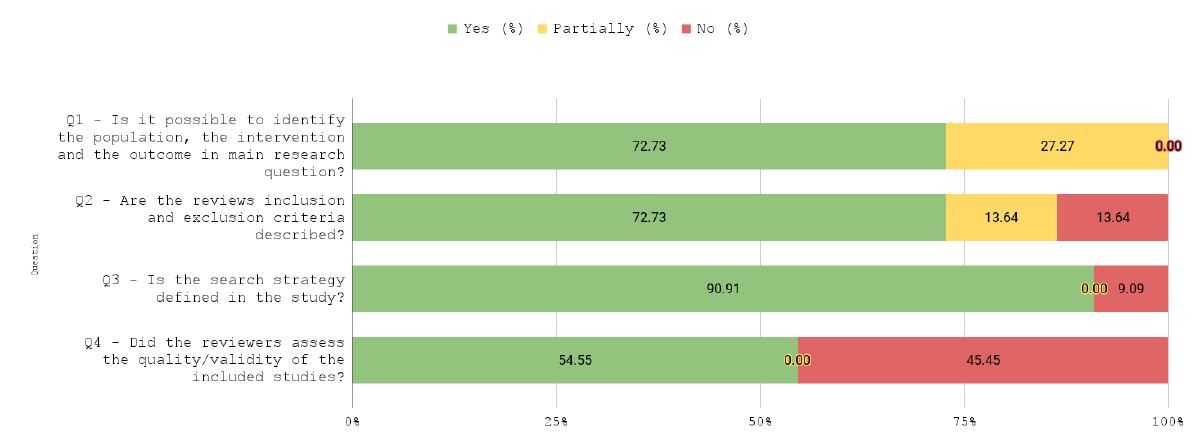
Figure 6. Answers to specific systematic reviews